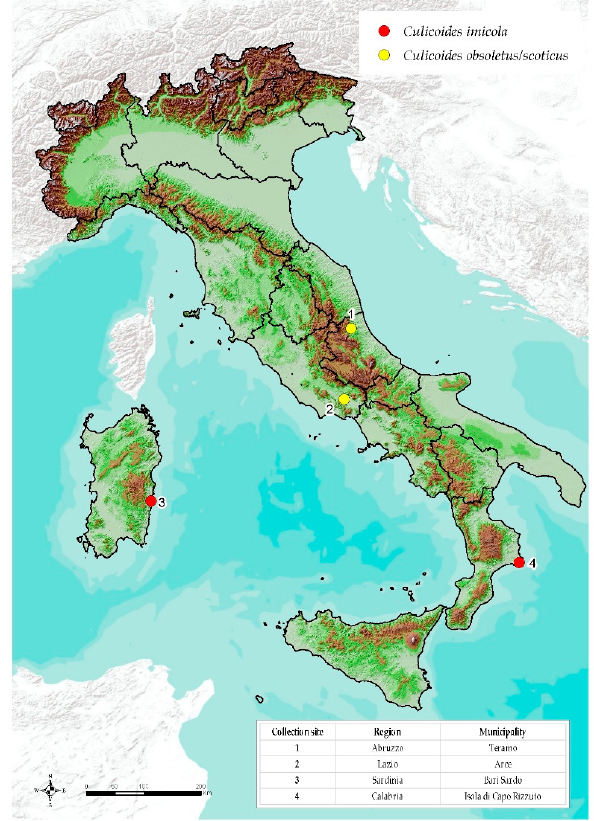
Figure 1. Location of the Italian population of Culicoides obsoletus/scoticus (Abruzzo and Lazio regions) and Culicoides imicola (Sardinia and Calabria regions).